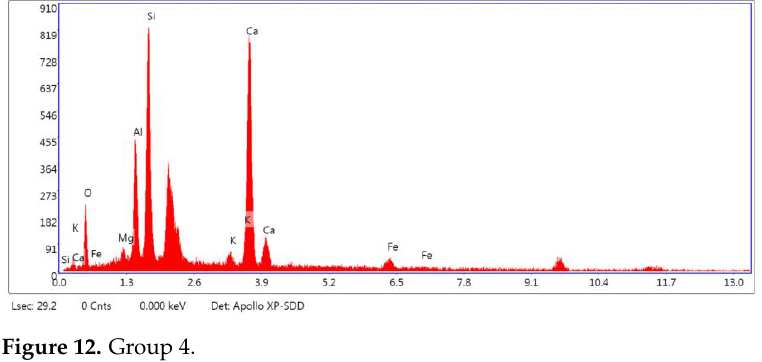
Figure 12. Group 4. Figure 12. Group 4.